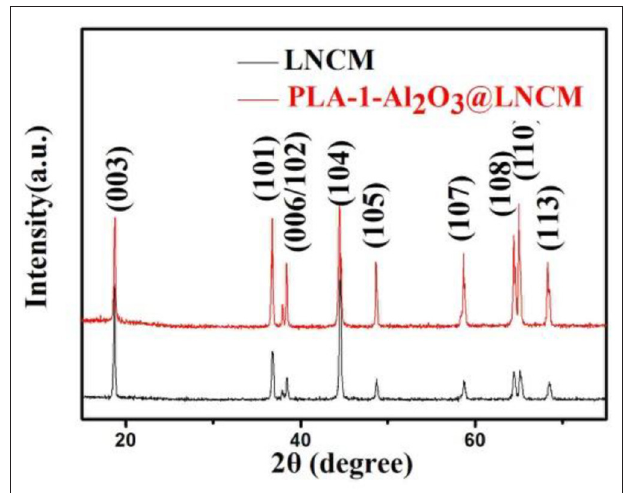
FIGURE 1 | Powder X-ray diffraction patterns of LNCM and PLA-1-Al 2 O 3